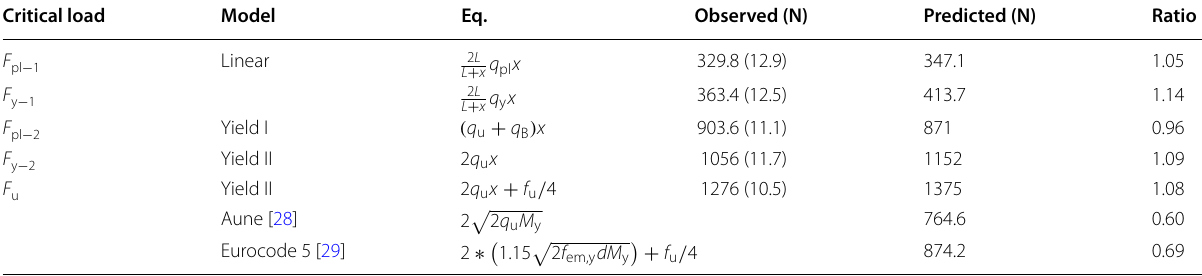
Linear Yield II Aune